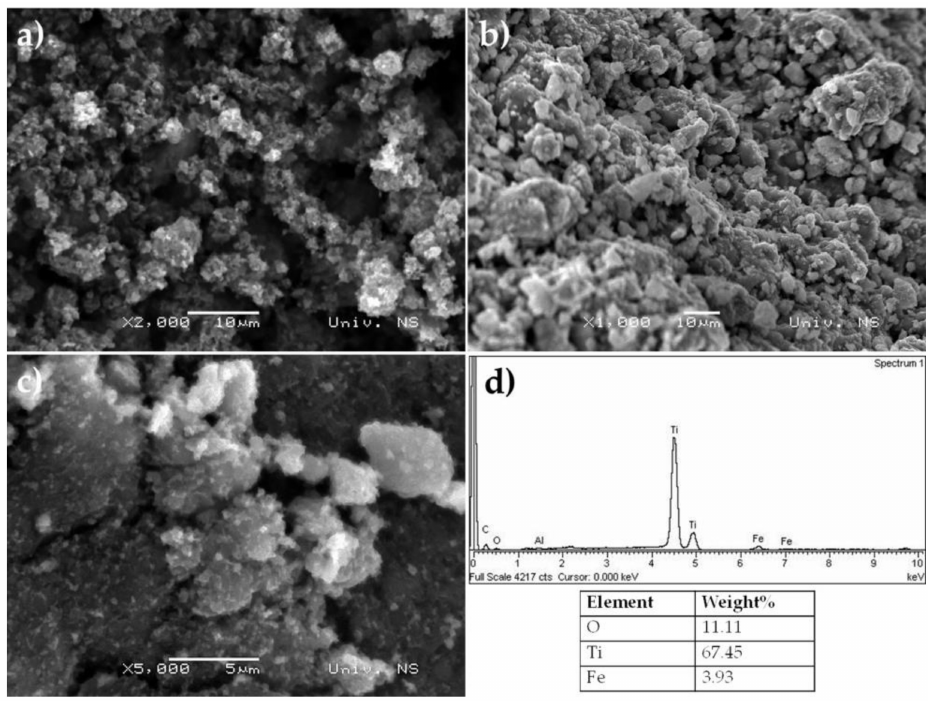
Figure 1. SEM images of ( a ) Fe 3 O 4 ( b ) TiO 2 and ( c ) TiO 2 –Fe 3 O 4 and EDX of ( d ) TiO 2 –Fe 3 O 4 .